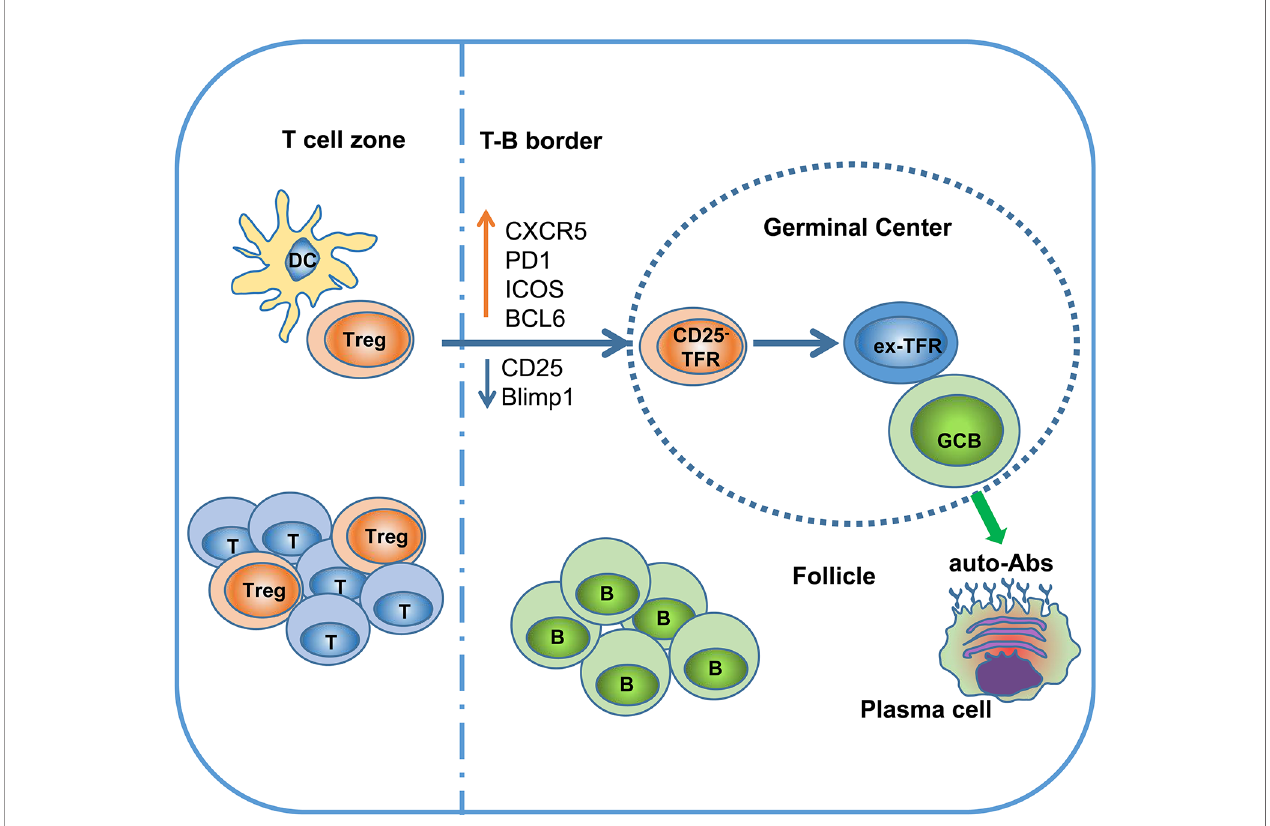
FIGURE 1 | Ex-TFRs: a missing piece of the SLE puzzle. Naïve Treg cells can interact with dendritic cells (DCs) to become activated and further migrate into the germinal center (GC) region through upregulation of CXCR5 and BCL6. In the follicle and GC, TFRs play an important role in regulating antigen (Ag)-speci fi c TFHs and antibody-secreting cells. Since the GC is not favorable to stable Foxp3 expression, some TFRs will lose Foxp3 and develop into pathogenic TFHs (ex-TFRs). Ex-TFRs tend to recognize self-antigens, which may promote autoreactive humoral